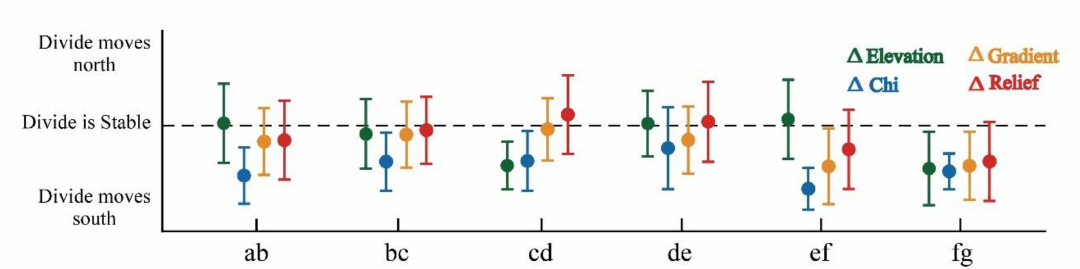
Figure 6. Standardized delta plot for the 6 segments (ab, bc, cd, de, ef, and fg segments) along the divide. Bars are considering standard deviation as the uncertainty. It should be noted that all the calculations on the Gilbert metrics and χ were determined with a base level of 700 m. The results are calculated by the DivideTools [14] based on TopoToolbox